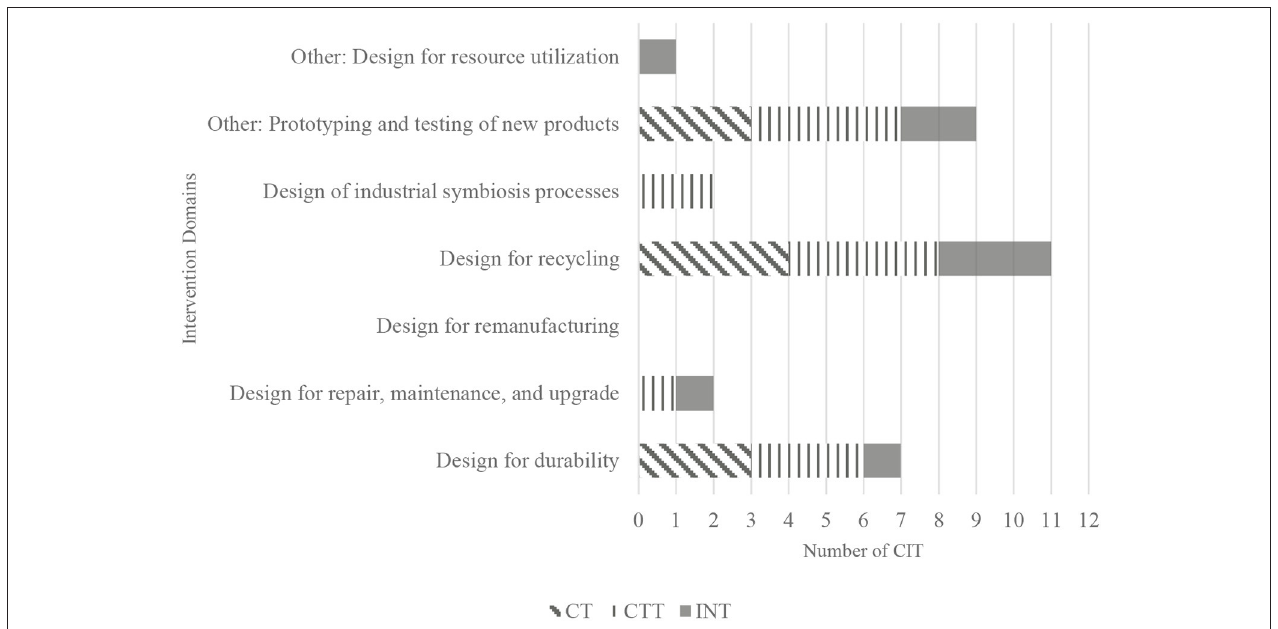
FIGURE 5 | Circular design/redesign intervention